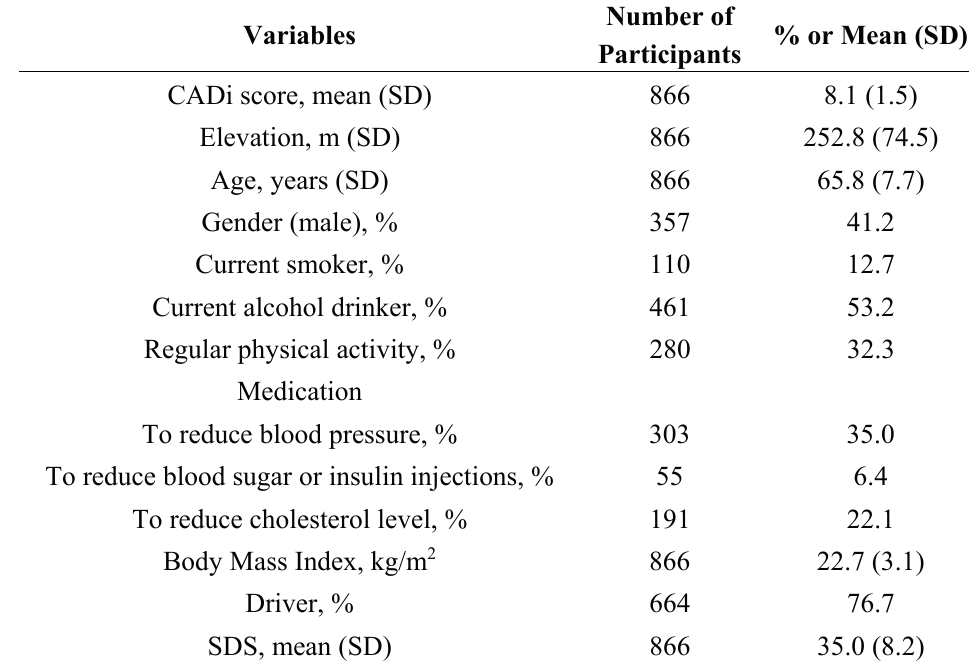
Table 1. Characteristics of the study